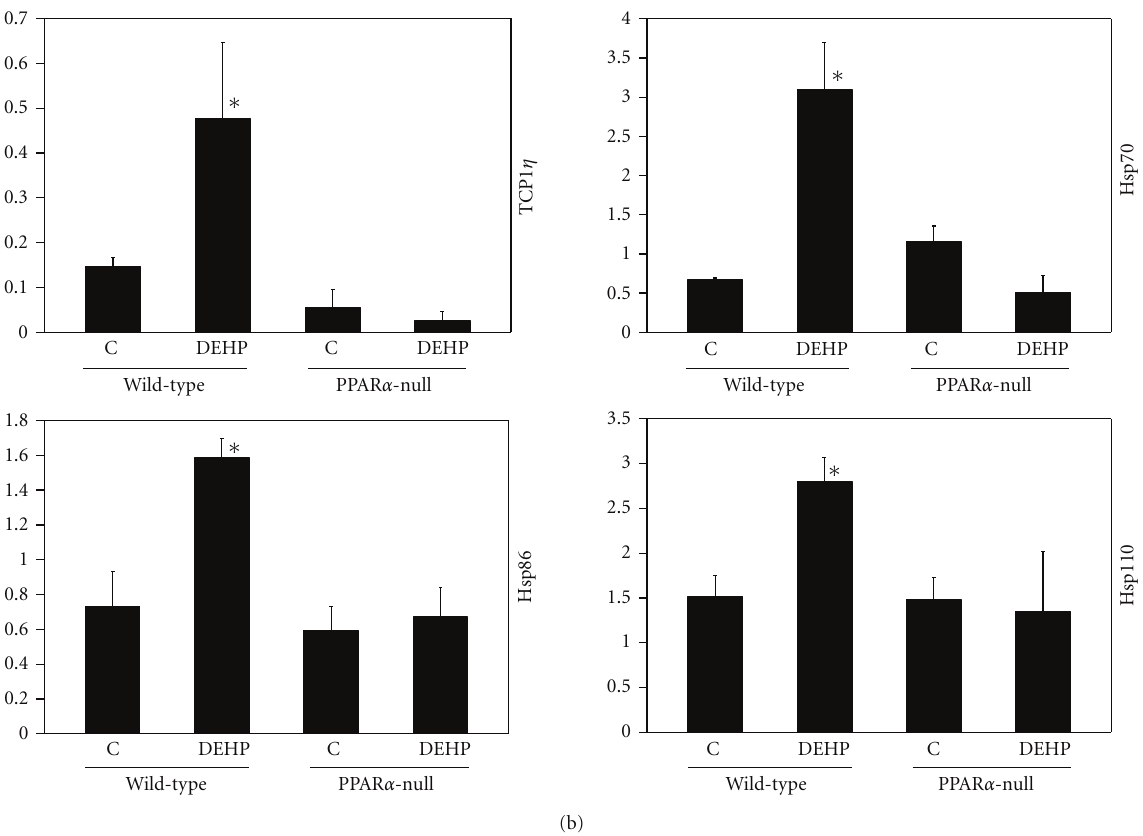
Figure 5: Expression of chaperone proteins after PPC treatment. (a) Protein expression in the livers of mice treated with di ff erent doses of WY. B6C3F1 mice were treated with the indicated concentrations of WY in the diet for 6 days. Protein expression was assessed by Westerns using primary antibodies against the indicated proteins. Blots were quantitated as described in Section 2. (b) Protein expression in livers of wild-type and PPAR α -null mice after exposure to DEHP. Proteins were extracted from the livers of wild-type or PPAR α -null mice given 7 consecutive doses of DEHP (1000mg/kg day). There were 3 animals per treatment group. Variability is expressed as standard error of the mean. Means and S.E. ( n = 3) for western data were calculated by Student’s t -test. The level of significance was set at P ≤ . 05 and significance is indicated with ∗